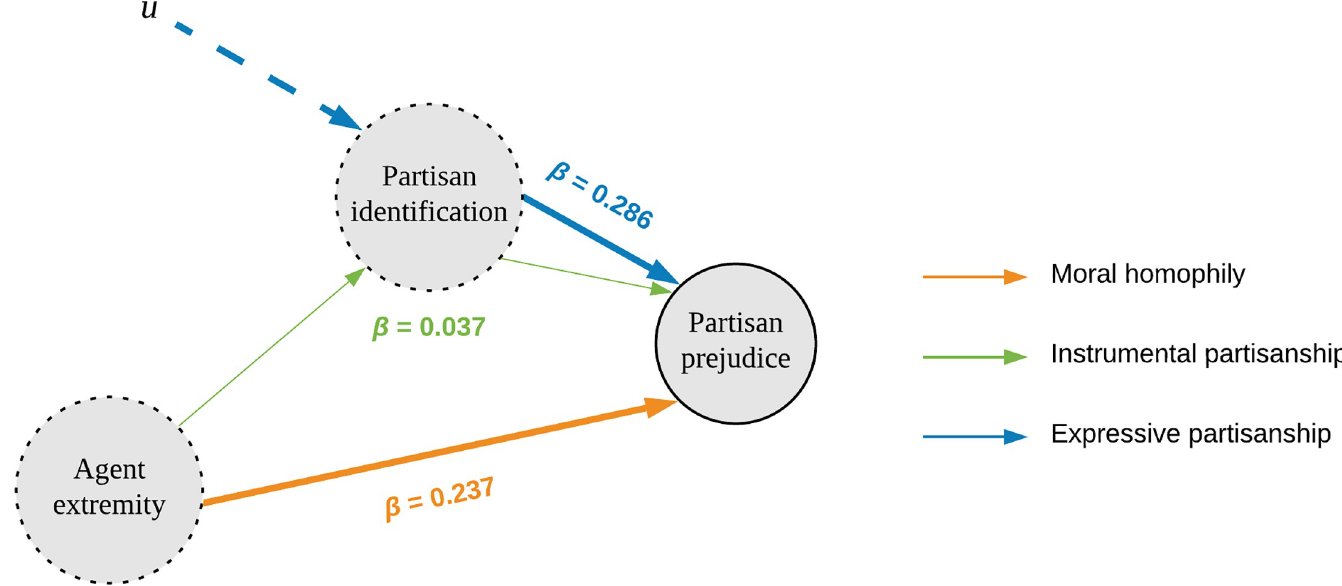
Fig 5. Path model of ideology and identity-based